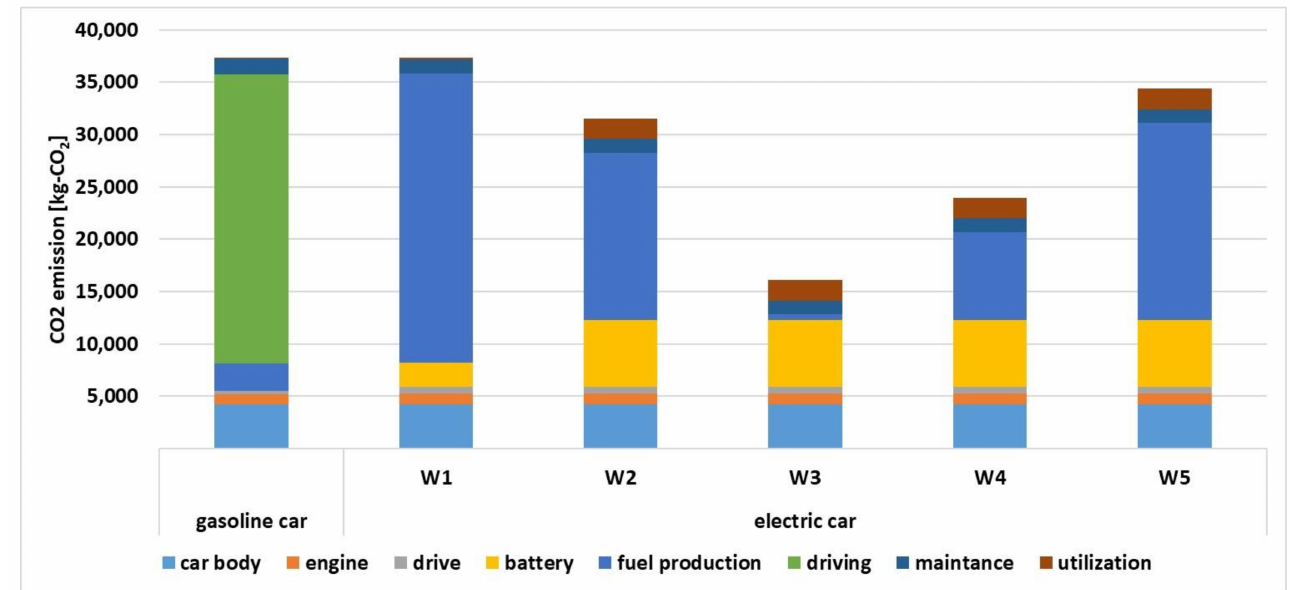
Figure 3. Emissions in kg-CO 2 for the entire life cycle of the cars (150,000 km, 10